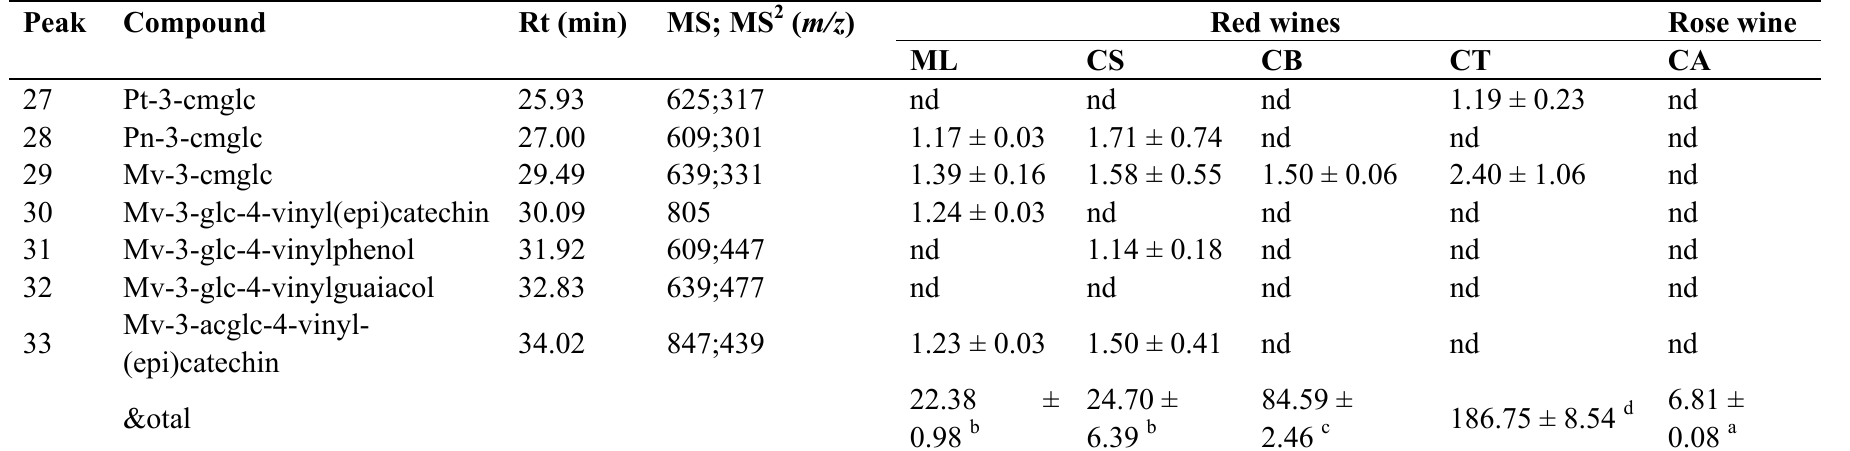
The abbreviations of the cultivars are the same as Table 1. Values are means of duplicate determination ±S.D. nd means not detected. tr means trace.